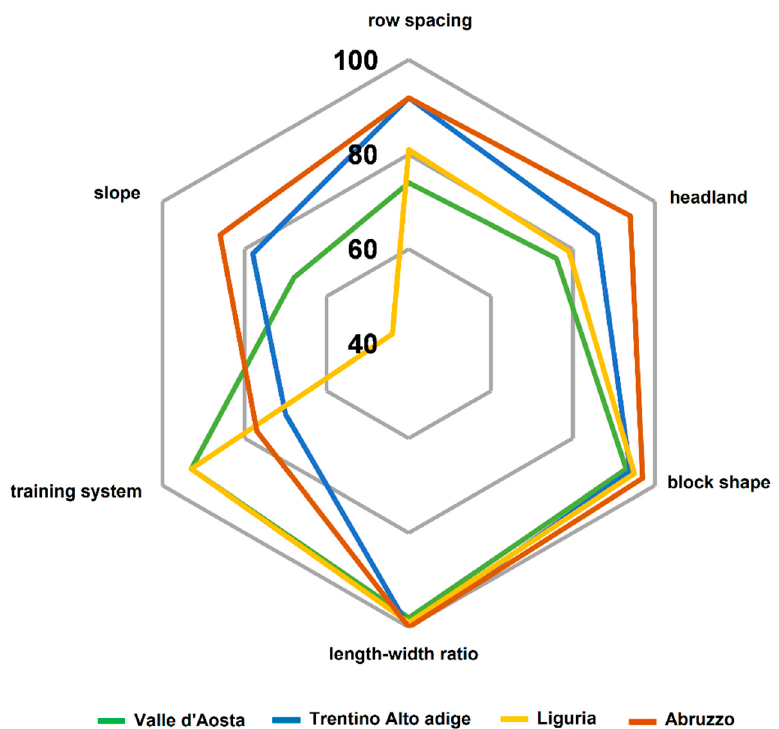
Figure 10. Kiviat diagram of the influence of the parameters considered on low-mechanisability regions. The score from 40 to 100 indicates the percentage of mechanisability as a function of every contributing parameter.